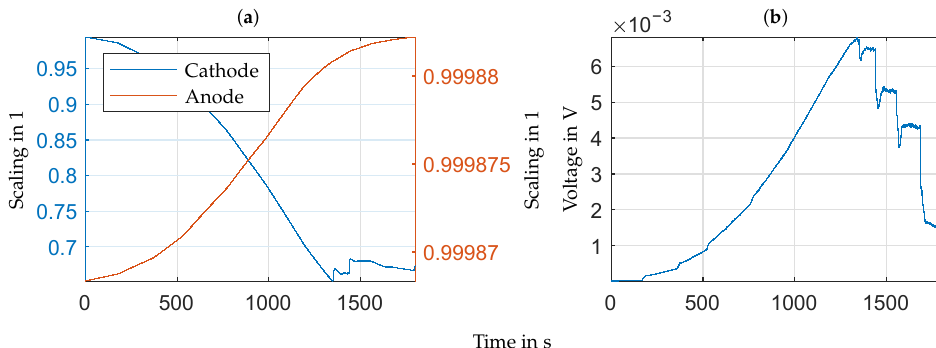
Figure 8. Flooding effects on electrochemical reaction due to EMT (Bruggeman relationship). The effective diffusivity scaling term ( a ) reduces the bulk diffusivity, which subsequently affects the voltage. Plot ( b ) shows the absolute voltage deviation